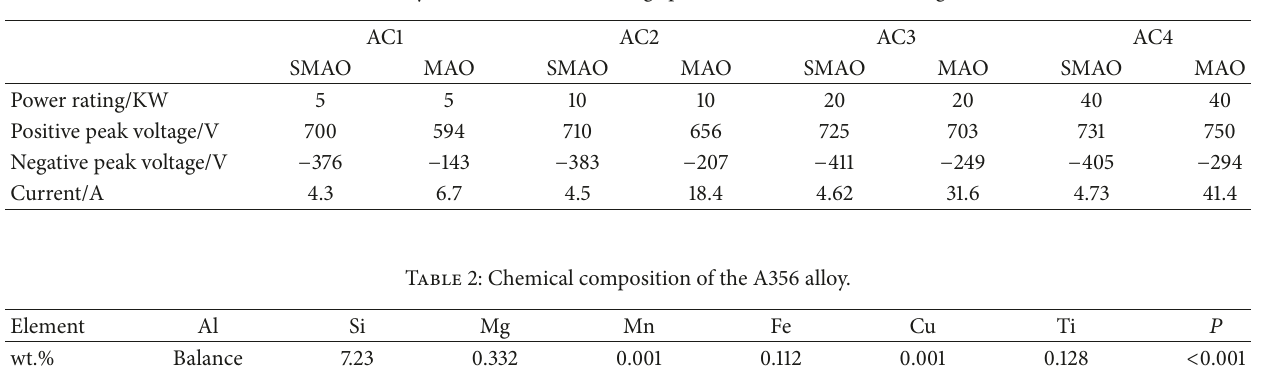
Table 1: Summary of AC current and voltage parameters used in the investigation.